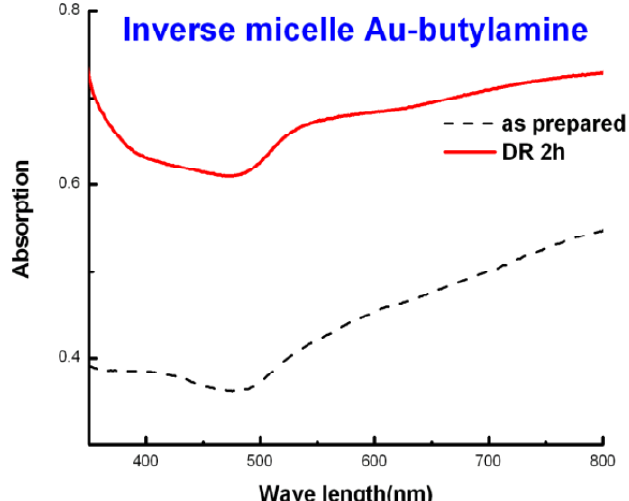
Figure 5. UV-Visible spectrum of Au-butylamine colloid by inverse micelle method before and after digestive ripening 2